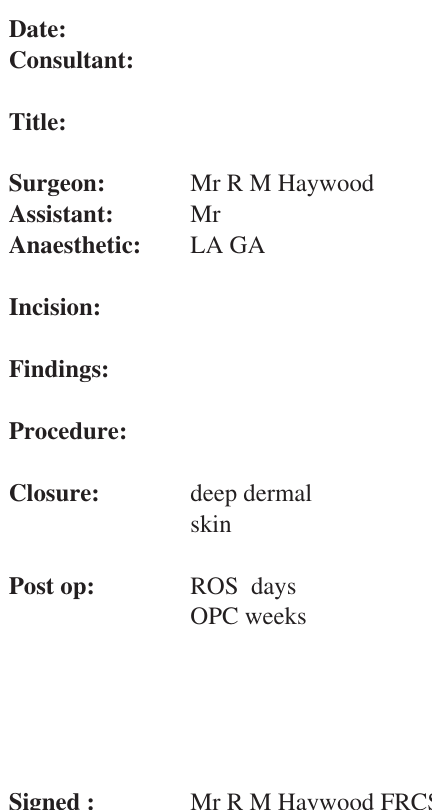
Figure 1. Blank word